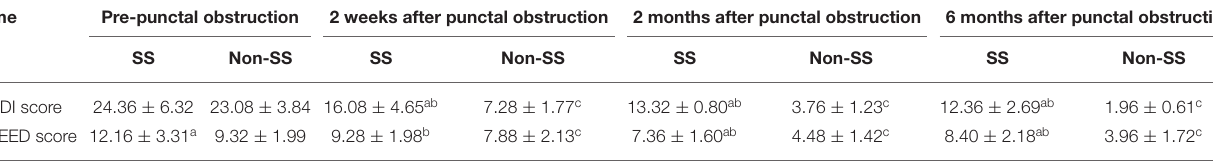
TABLE 1 | Changes of mean SPEED and OSDI scores in SS and Non-SS group after punctal obstruction. Time